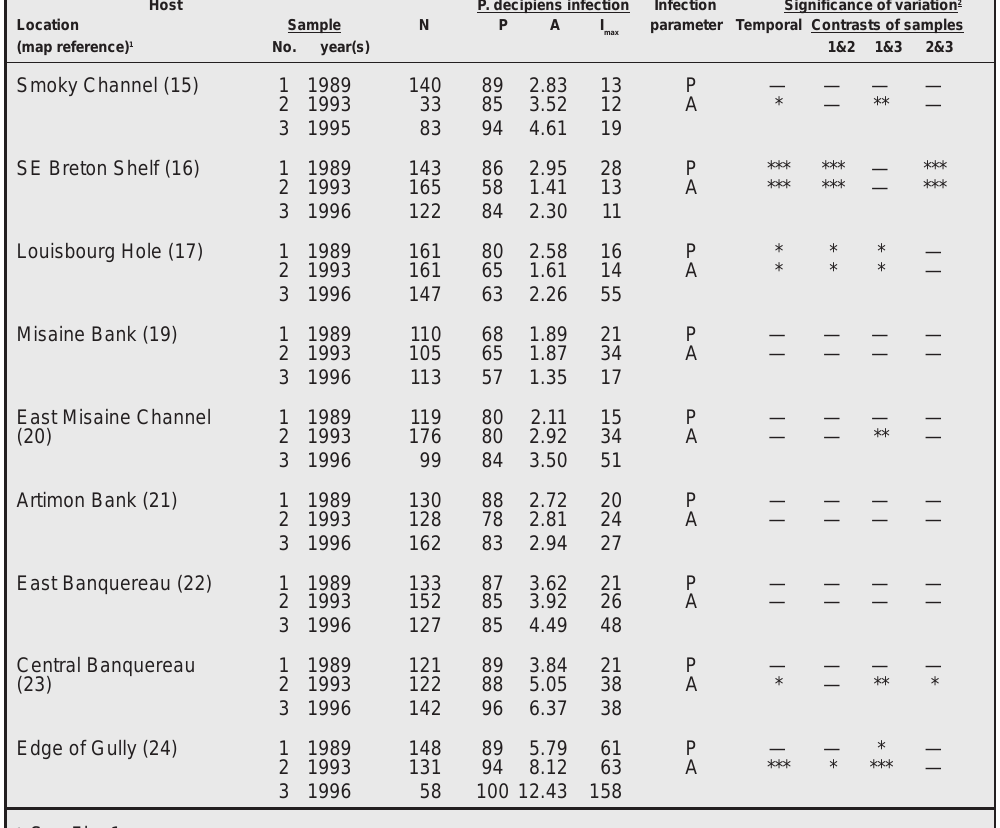
Table 2 . Prevalence (P), abundance (A) and maximum intensity (I infection in Hippoglossoides platessoides , 31-40 cm in length, from the Breton and eastern Scotian shel- ves, with temporal contrasts of prevalence and abundance.